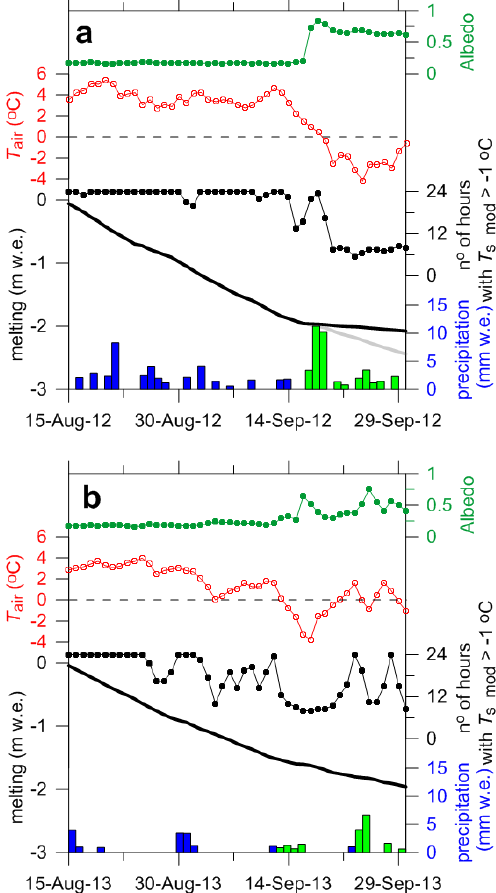
Figure 13. Comparison of computed cumulative melting (black thick line) between 15 August and 30 September from summers 2012 (a) and 2013 (b) . Also shown are the mean T air (red open dots), the number of hours in a day when T s_mod is > − 1 ◦ C (black dots), daily albedo (dark green dots) and the precipitations as rain/snow obtained from records at base camp (blue and green bars, respectively). The grey line in (a) is the computed cumula- tive melting between 15 August and 30 September 2012 assuming a constant surface albedo of